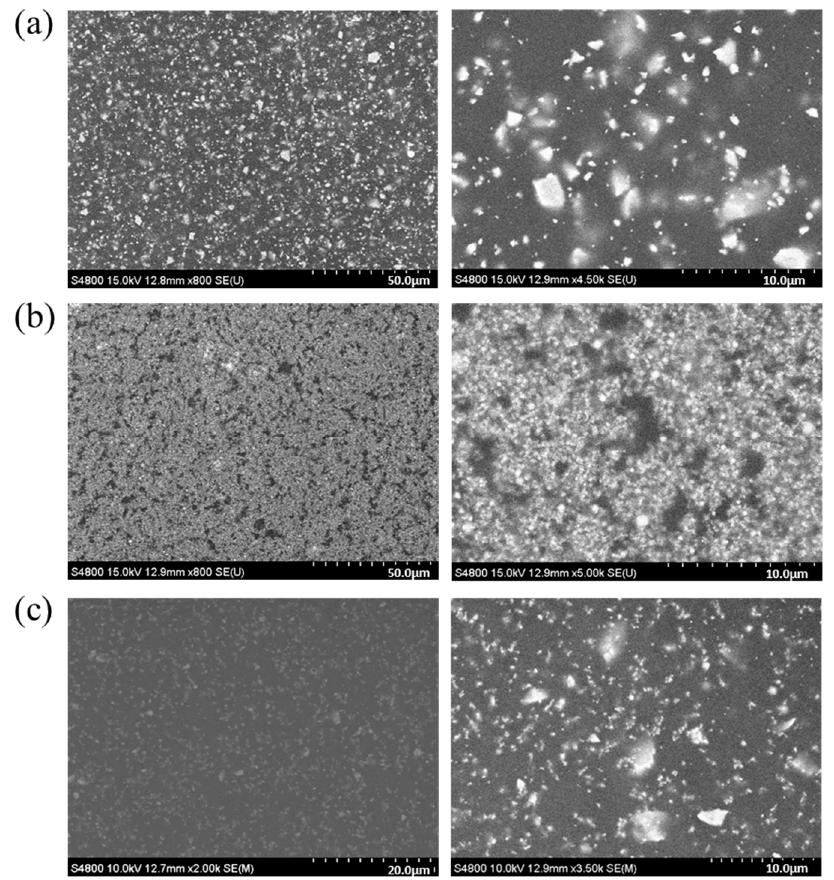
Figure 3. SEM images of the ( a ) PZT-, ( b ) SMA- and ( c ) PZT + SMA-particle-dispersed mixture films.